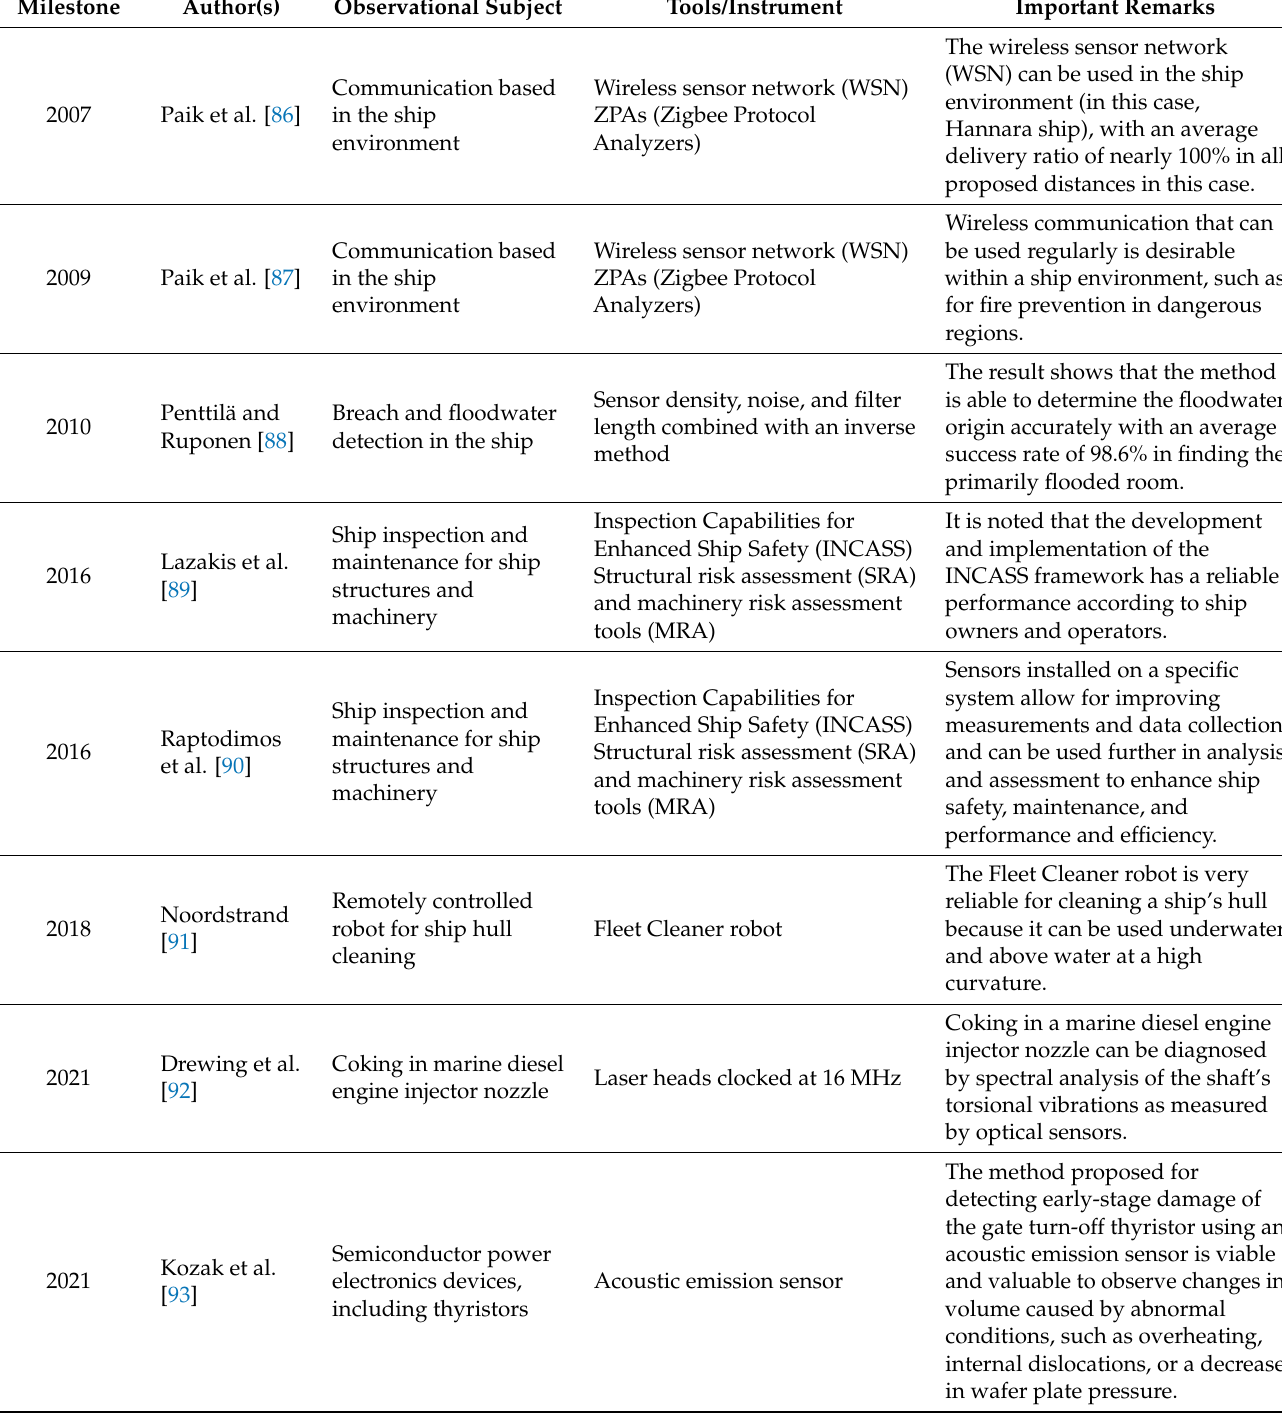
Table 4. Research landmark of the advanced machinery performance